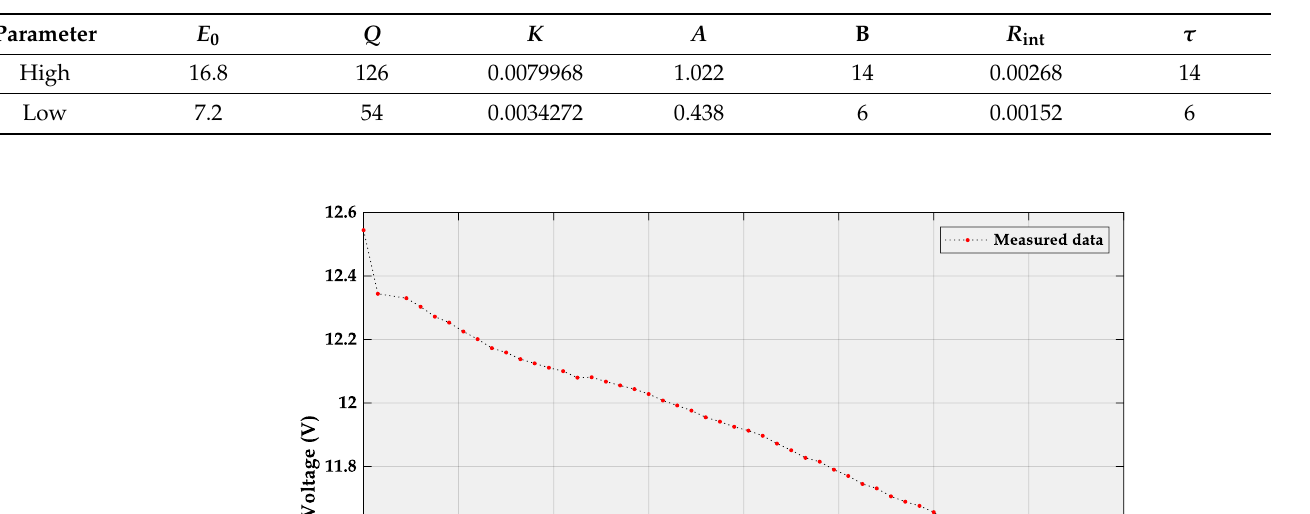
Table 6. Search space limits for Banner 120 Ah battery model.